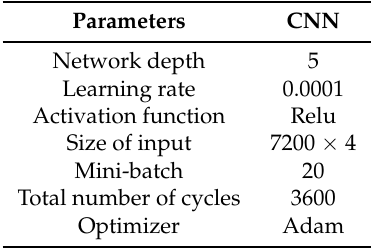
Table 2. Some parameters of neural network.